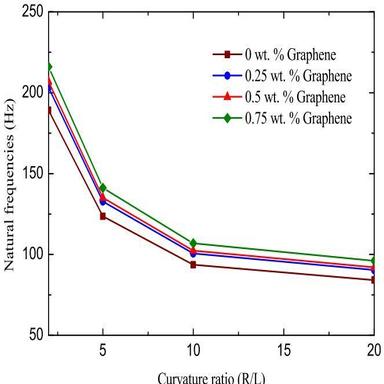
The effect of curvature ratios on the natural frequencies of GFRP panels with various wt% of graphene reinforcement under CCCC end conditions.